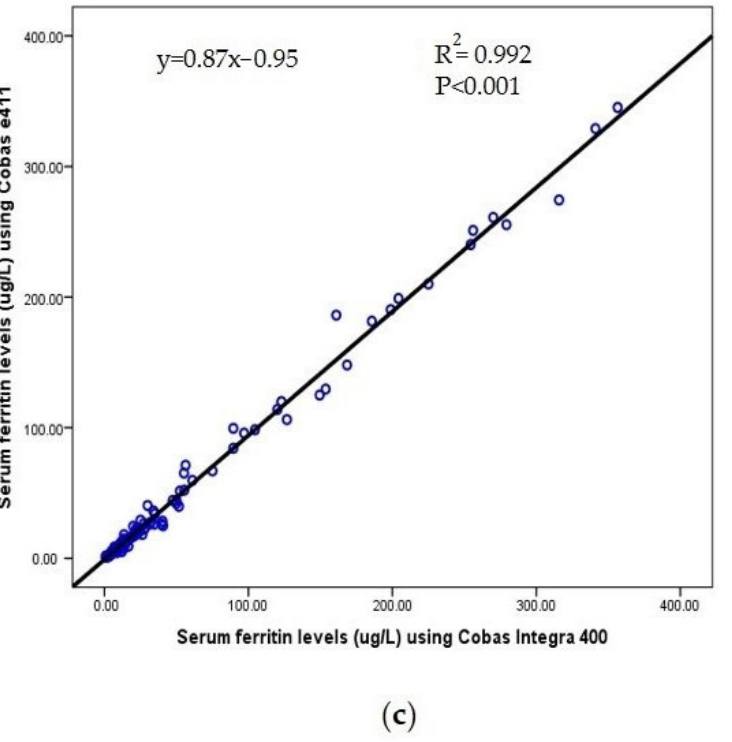
Figure 1. ( a ) Association between ELISA and Cobas e411 methods using linear regression analysis; ( b ) association between ELISA and Cobas Integra 400 methods using linear regression analysis; ( c ) association between Cobas e411 and Cobas e411 methods using linear regression analysis.